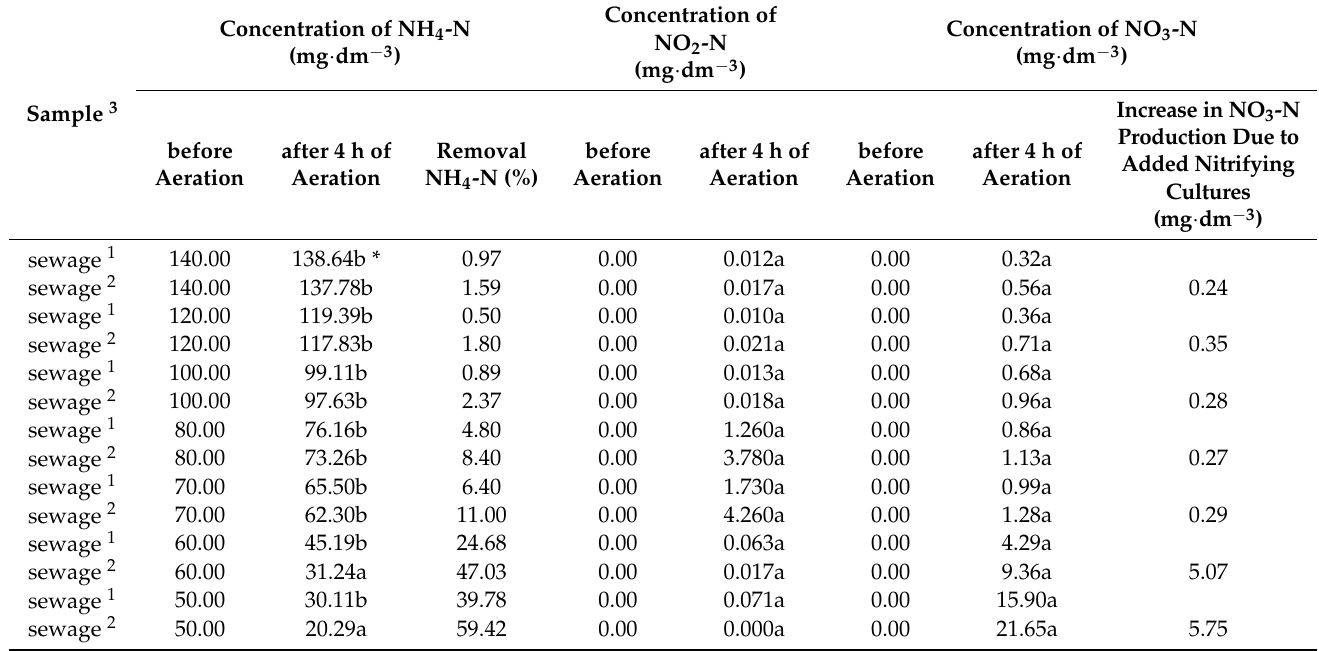
Table 3. The effect of TAN concentration on the activity of nitrifying bacteria—static conditions.